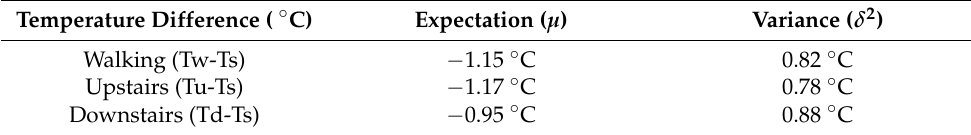
Figure 6. General workflow for temperature monitoring and adjusting. Table 8. Values of expectation and variance in the normal distribution